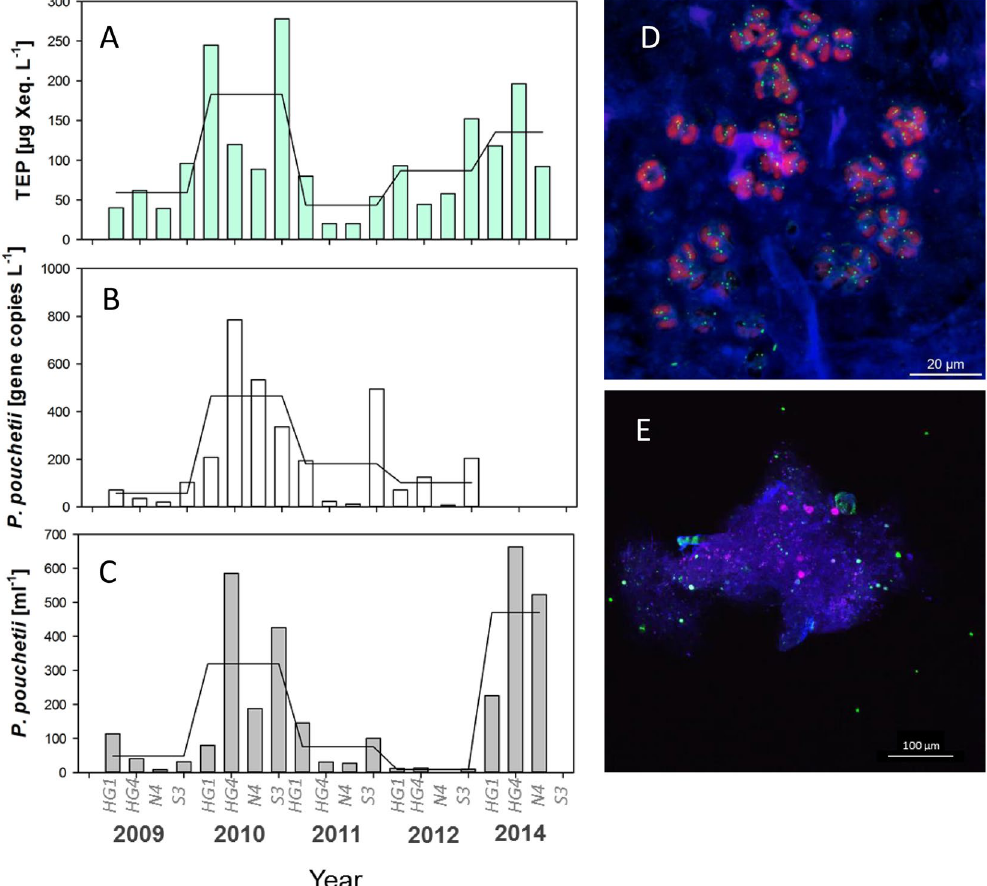
Figure 4. Concentration of TEP [( A ); µ g Xeq. L − 1 ] and abundance of P . pouchetii as determined by 454 sequencing [( B ); sequence abundance in this analysis] and q-PCR analyses [( C ); ml − 1 ] at four time series stations from 2009 to 2014. Association of polysaccharide gels (TEP) with P . pouchetii ( D ) and within sinking particle aggregates ( E ) as determined by confocal laser scanning microscopy (CLSM) using a conjugate of Concanavalin A and Alexa Fluor 633 to stain polysaccharide gels (blue), SYTO 9 to stain bacteria (green) and Chl a autofluorescence (red). Pictures by Jan Michels (D) and Kathrin Busch